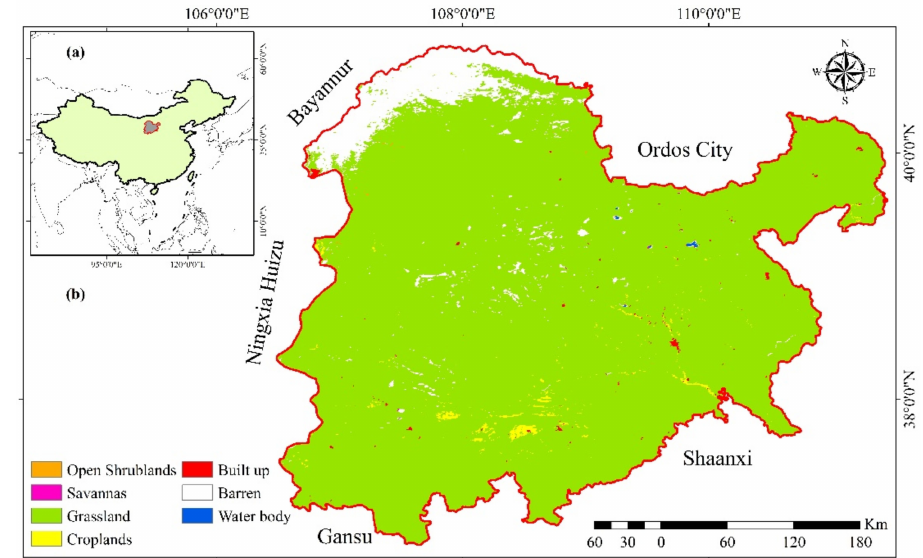
Figure 1. ( a ) Location of Mu Us Desert ( b ) Different land use